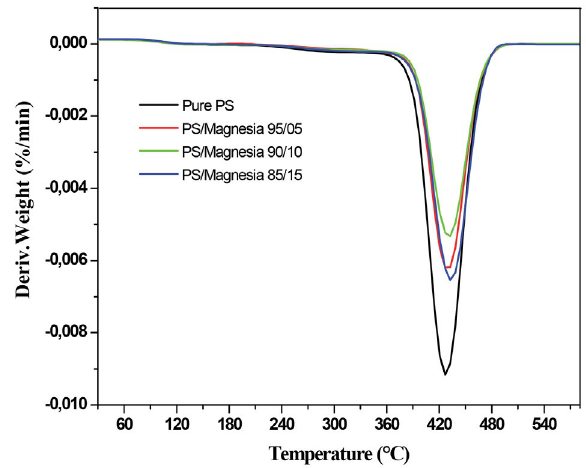
Figure 6: DTG curves of neat polystyrene and PS/Magnesia com-